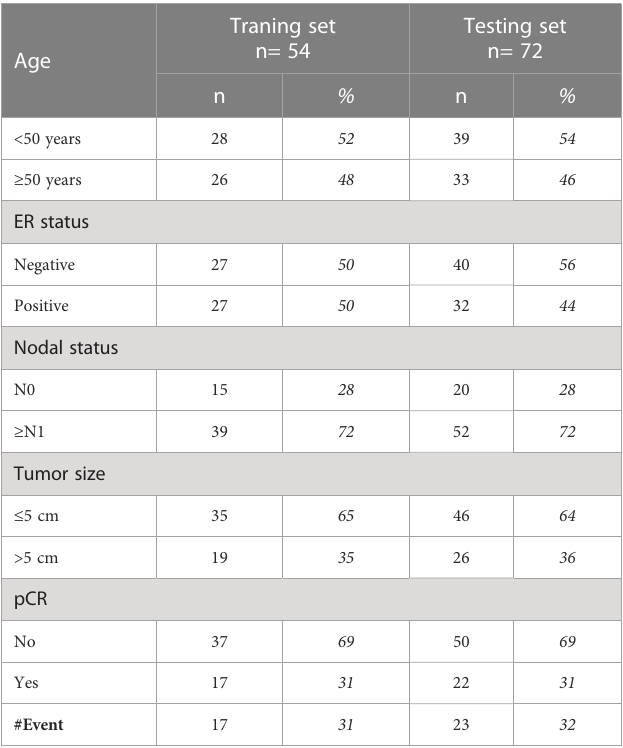
TABLE 1 Clinico-pathological features of the training and testing